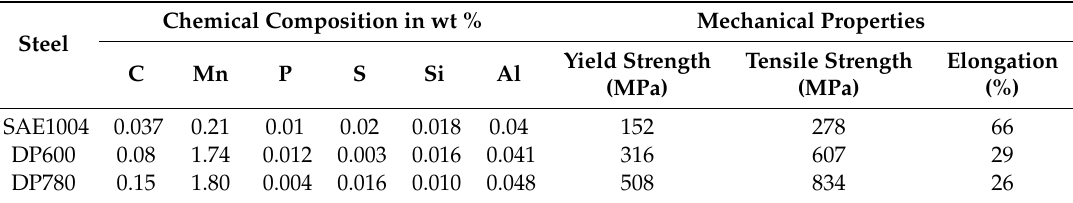
Table 1. Chemical composition in wt % and mechanical properties of the steel materials.